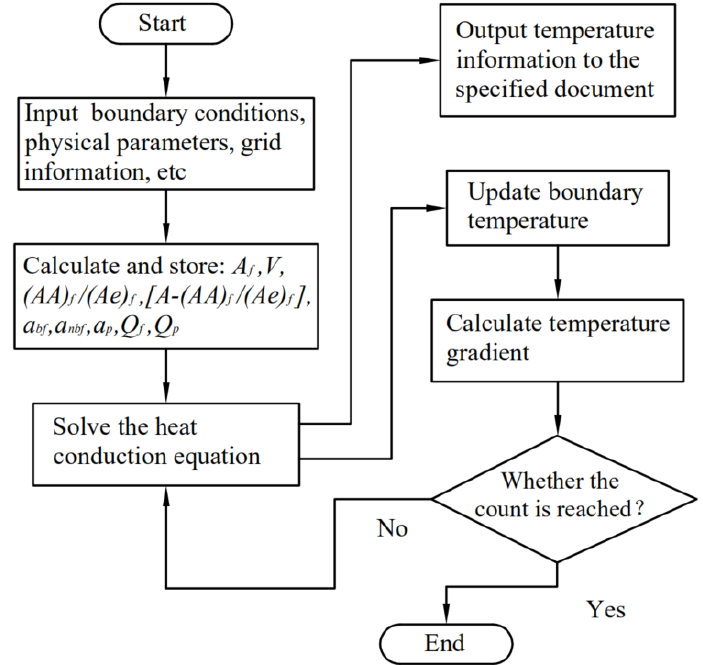
Figure 11. Flowchart for temperature rise calculation.